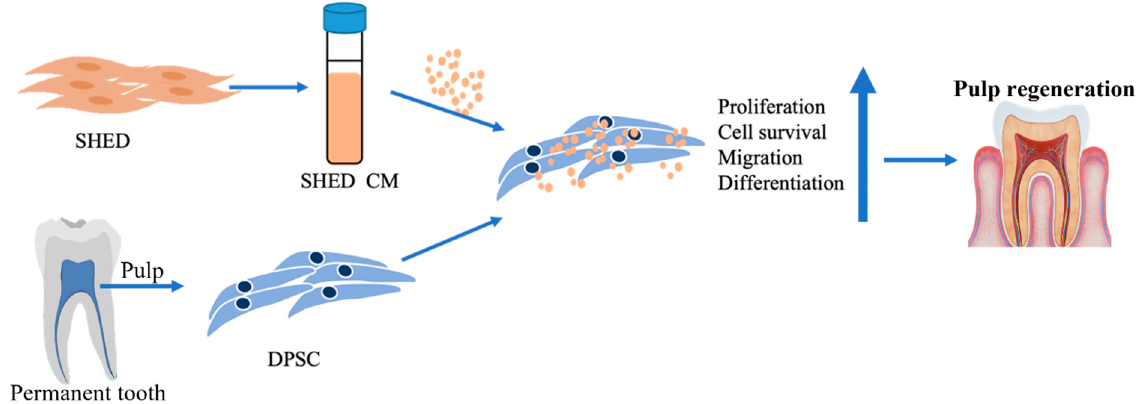
Figure 6. Schematic diagram of the effect of SHED CM on DPSC culture and odontoblast differen- tiation. SHED CM increased cell proliferation and progenitor cell recruitment, protected cells from oxidative stress, and enhanced cell differentiation.